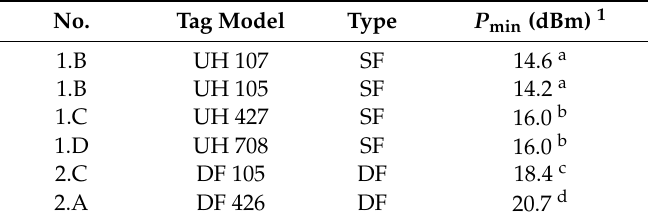
Table 6. Tag factor e ff ects. Mean values of the minimum power needed to activate the tag ( P min (dBm)) for each of the considered tags when in proximity to minced meat patties (in the 2.50–18.75